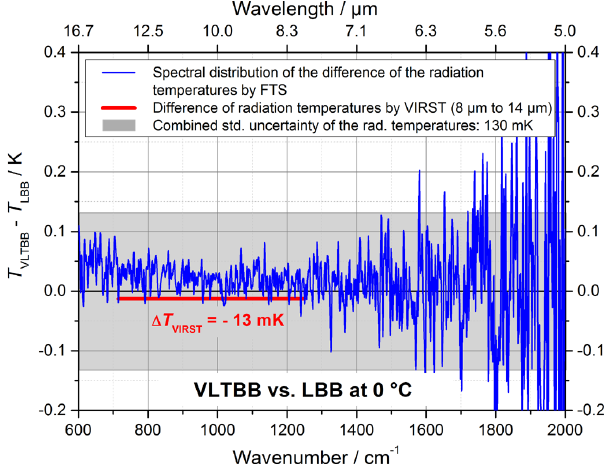
Fig. 10. Difference between the radiation temperatures of the VLTBB and the LBB at 0 ◦ C measured with the vacuum FTS (blue line) in the relevant wavelength range of the GLORIA instrument and with VIRST (red line) at the RBCF. Table 4. Maximum individual deviation of the measured radiation temperature from the fitted calibration curve (fourth-power polyno- mial) for each PRT with the corresponding standard uncertainty u of the radiation temperature measurement.